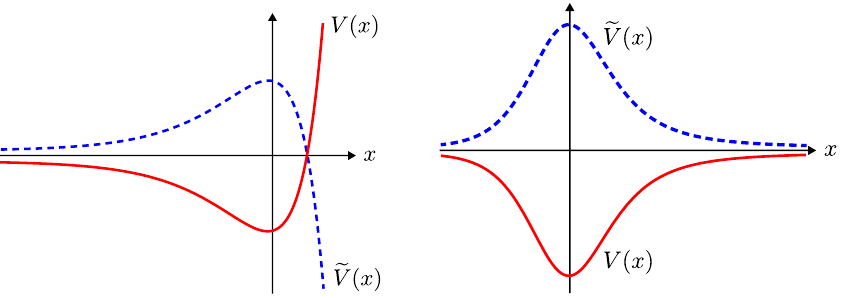
Figure 2. In this article, we mainly consider two types of potentials. These appear in the Morse potential (8) ( left ) and in an effective potential (111) in the linear perturbation of the Schwarzschild spacetime ( right ). Both cases can be treated in a unified